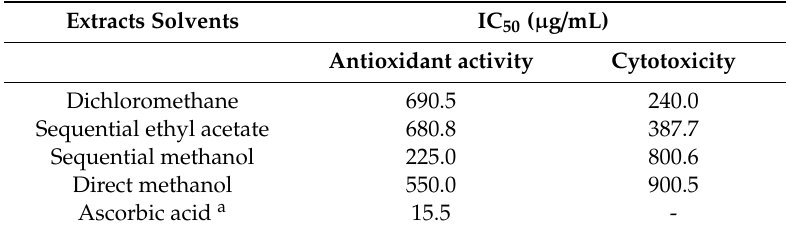
Table 4. Cytotoxic and antioxidant activity of root barks extracts of Euclea divinorum . Extracts